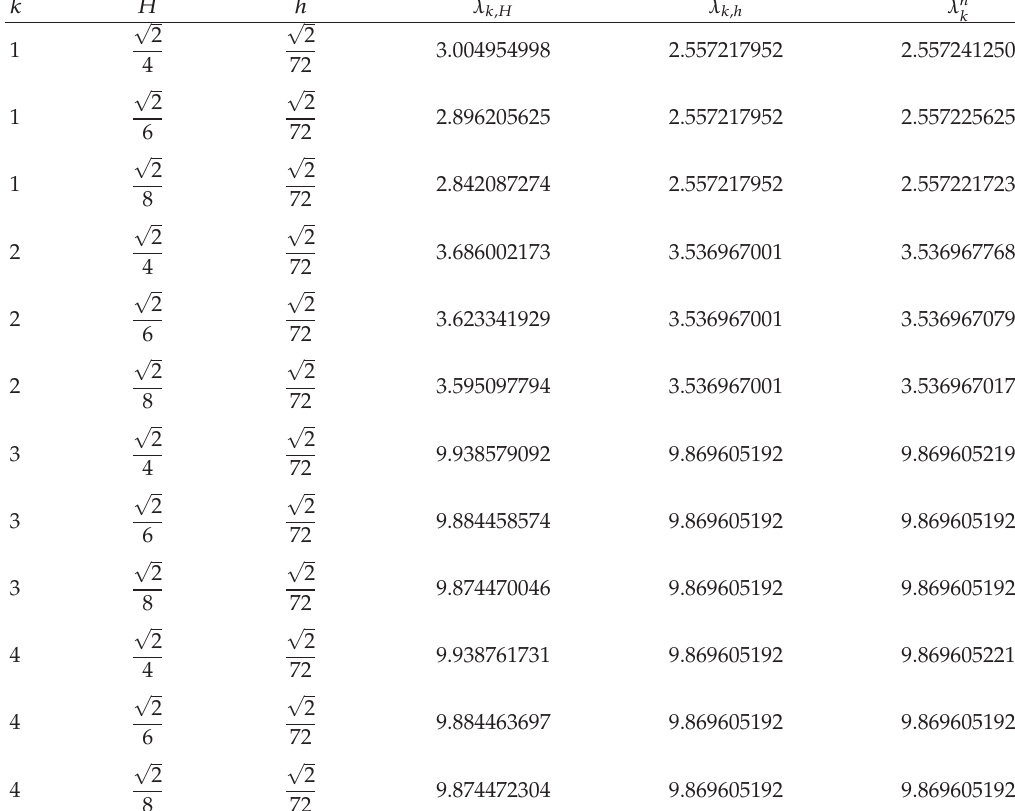
Table 3: The results on the L-shaped domain by Scheme 1 (cid:4) P 2 - P 1 element (cid:5) for eigenvalue problem